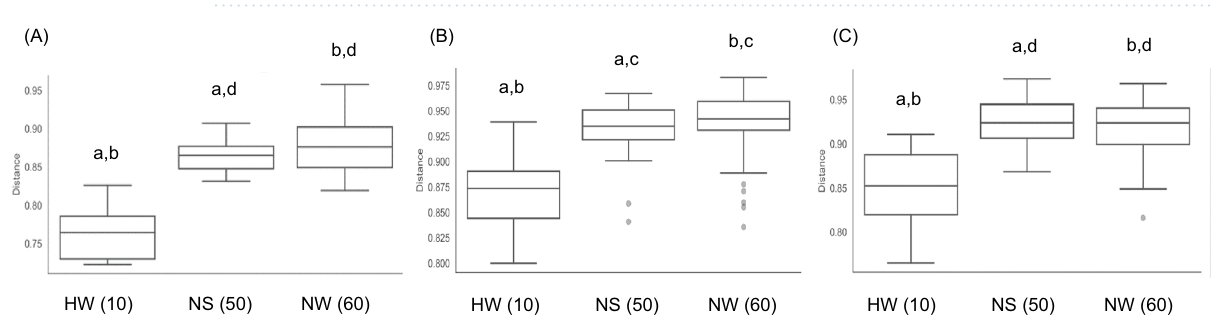
Figure 2. Beta diversity of ruminal microbial and chloroplast composition in amplicon-seq analysis. Beta diversity is shown using 3D plots of Jaccard distances. ( A ) Bacterial taxa in the 16S rRNA dataset, ( B ) eukaryotic taxa without chloroplasts and host mitochondria in the 18S rRNA dataset, and ( C ) chloroplast taxa in the 18S rRNA dataset. Circles indicate Hokkaido winter (HW) in red, Nagano spring (NS) in blue, and Nagano winter (NW) in orange.